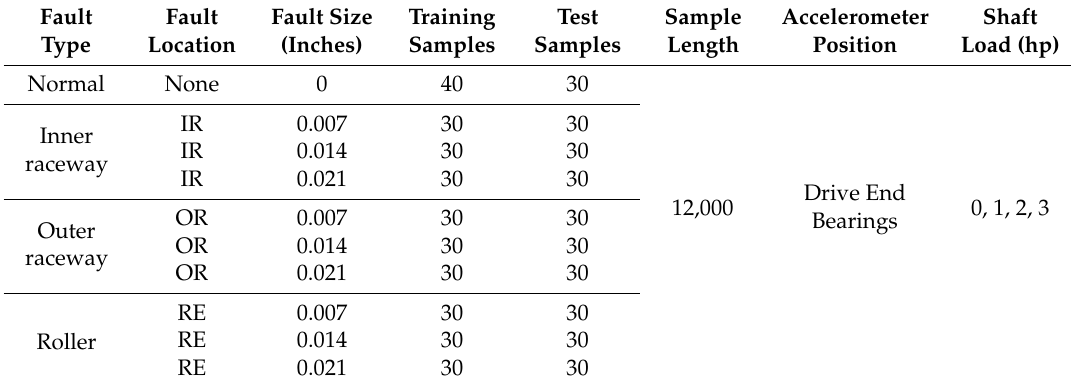
Table 3. Bearings and dataset specification.